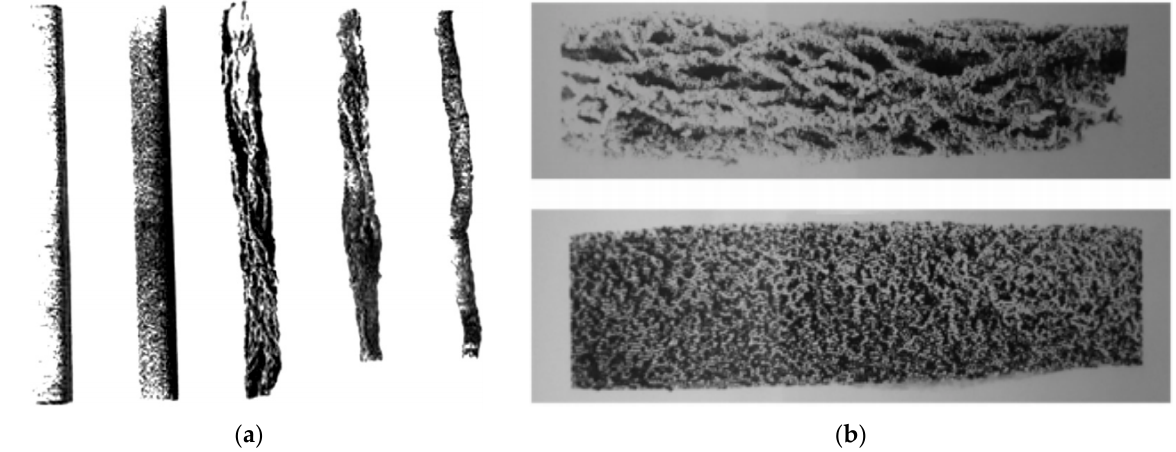
Figure 5. Effect of processing conditions on EDC: ( a ) similarly processed steel powders with different oxide thickness (from left to right, as received and annealed up to 60 min at 500 °C), reprinted with permission from ref. [62], Copyright 2009 Elsevier; ( b ) similar powders processed with 1.85 kV (top) and 5 kV (bottom), reprinted with permission from ref. [29], Copyright 2020 Taylor &